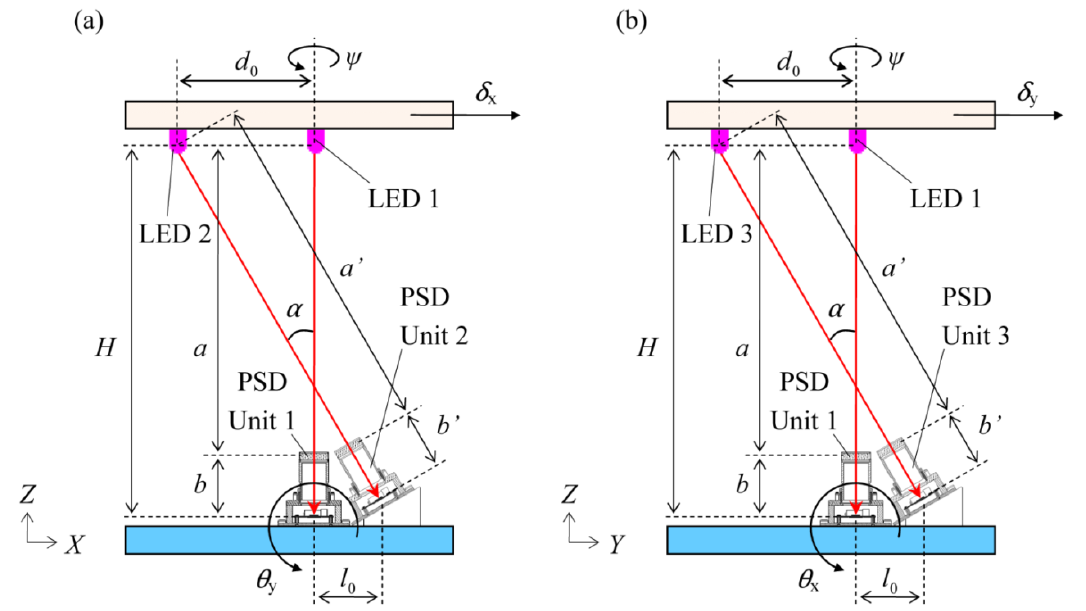
Figure 2. Cross-section view of the relative-story displacement sensor. (a) XZ -plane view and (b) YZ -plane